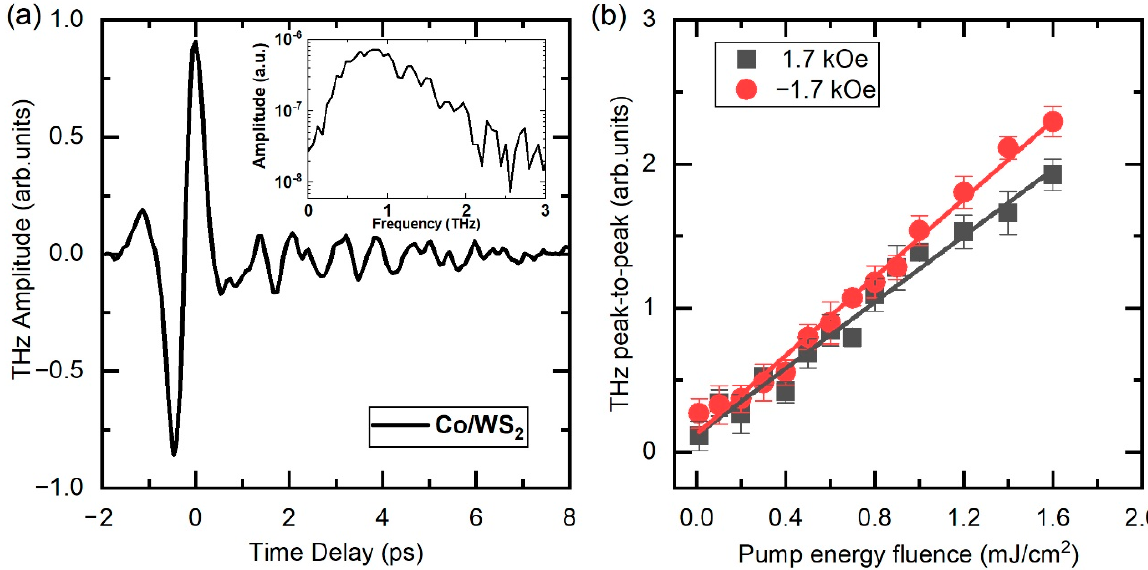
Figure 2. ( a ) Amplitude of terahertz radiation from Co/WS 2 structure in the time and frequency domains (inset). ( b ) THz peak-to-peak amplitude as a function of the pump energy fluence under different magnetic fields applied in the HA geometry.